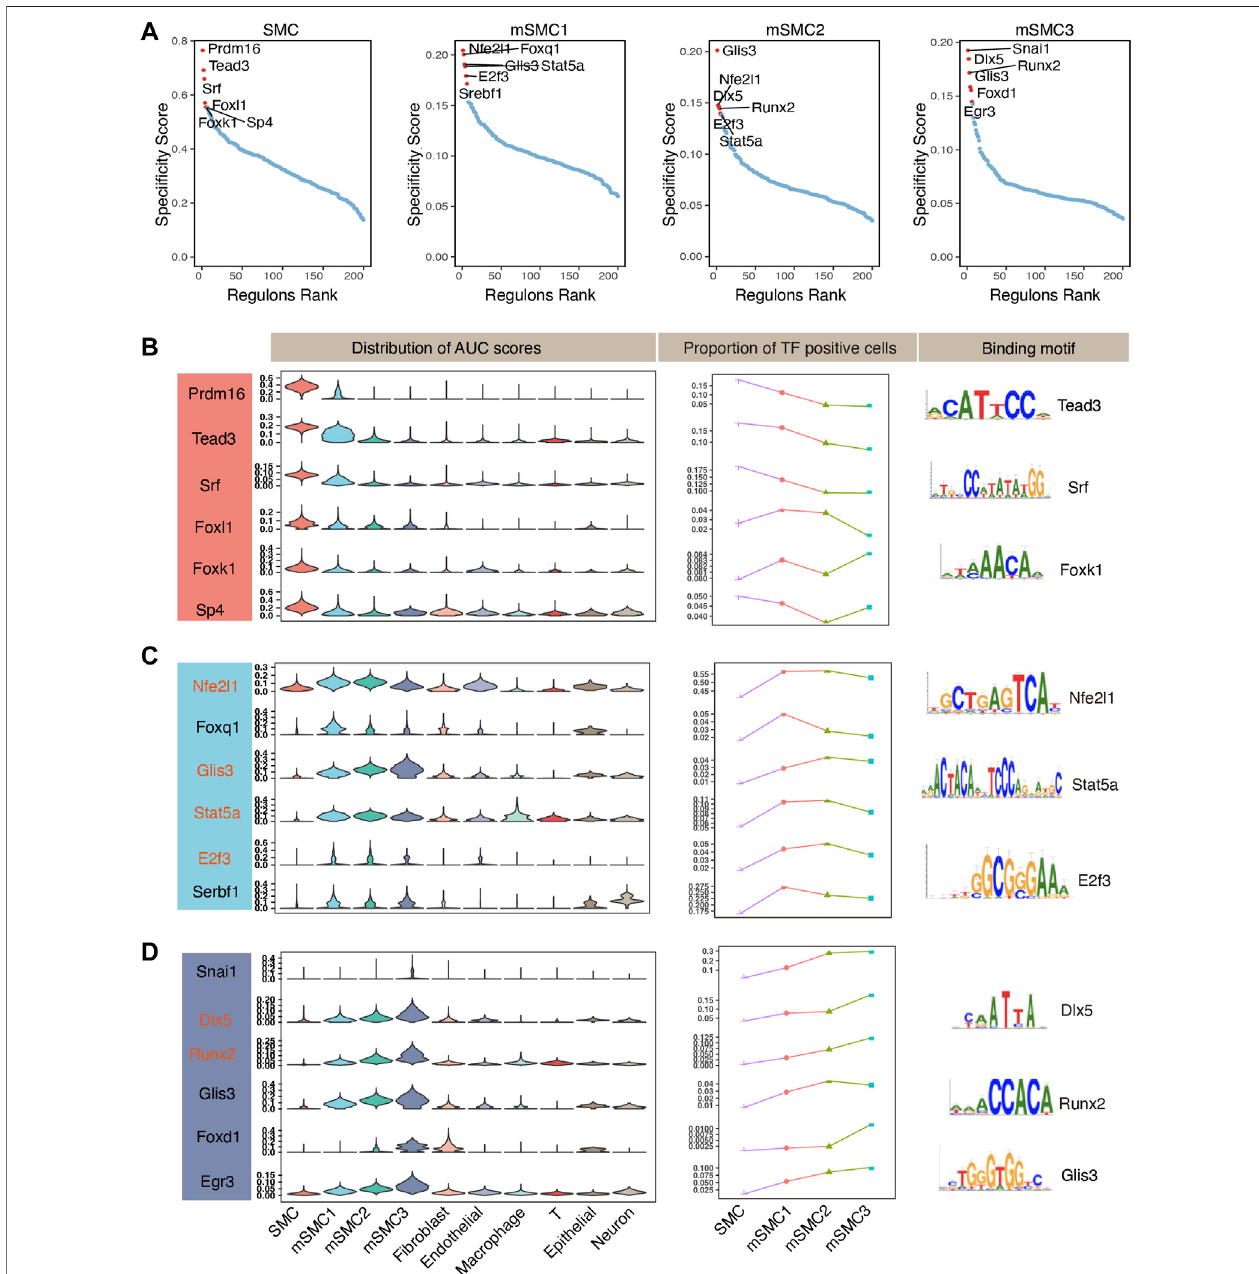
FIGURE 2 | Construction of gene regulatory networks in SMC-derived cells in atherosclerosis in mice. (A) Identi fi ed regulons were ranked based on their cell-type speci fi city scores in SMCs and mSMC subtypes. Key TFs of the top six speci fi c regulons for each cell type were designated. (B) Left panel shows distribution of AUC scoresofthetopsixspeci fi cregulonsforSMCs.ThepanelinthemiddlerepresentstheproportionofcorrespondingTF-positivecellsinSMCsandmSMCsubtypes.The rightpaneldisplaysbindingmotifsforrepresentativeTFsforSMCs. (C) Sameas (B) butformSMC1. (D) Sameas (B) butformSMC3.ConsideringmSMC2shares top speci fi c regulons with mSMC1 or mSMC3, the top 6 mSMC2-speci fi c regulons were highlighted in light red in (C,D) . SMCs, smooth muscle cells; mSMCs, phenotypically modulated SMCs; DEGs, differentially expressed genes; AUC, area under the curve.